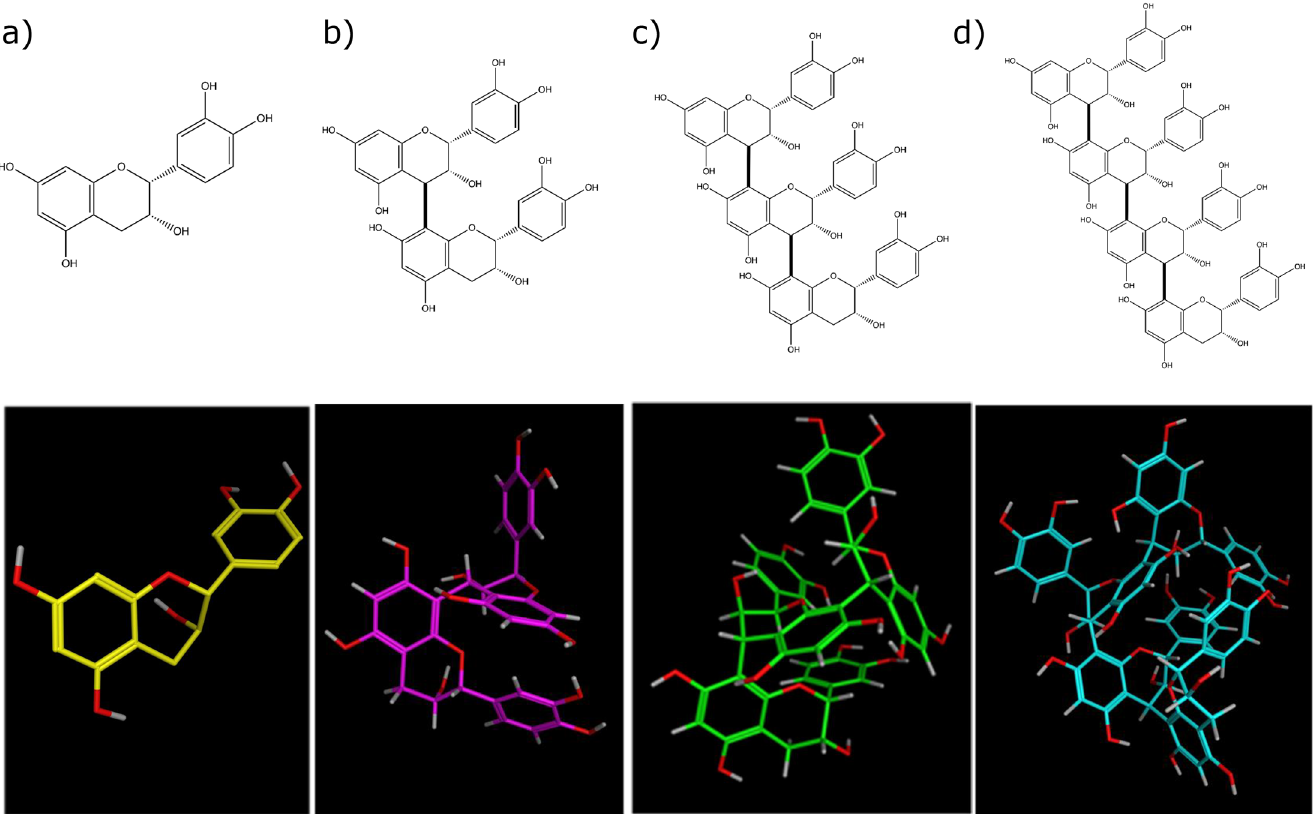
Fig 1. Structures of B type procyanidin. (a) (-)-epicatechin (EC; monomer), (b) procyanidin B2 (B2; dimer), (c) procyanidin C1 (C1; trimer), (d) cinnamtannin A2 (A2; tetramer).